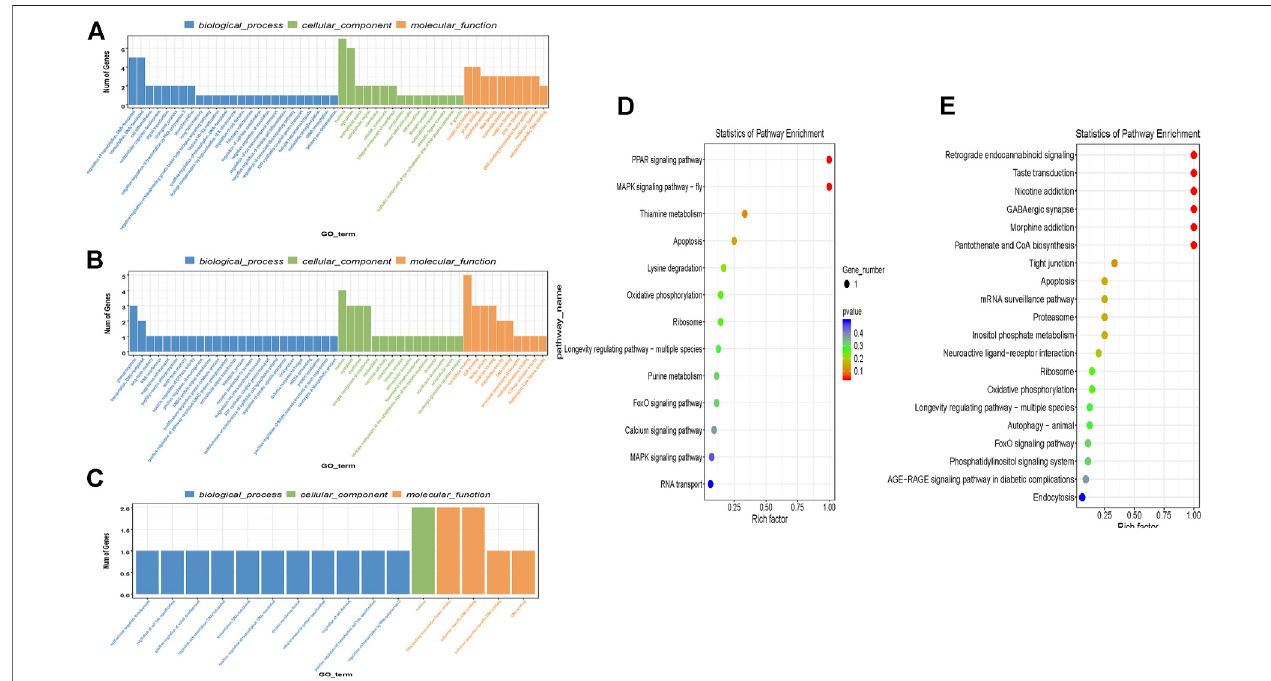
FIGURE3| GOandKEGGtermanalysisofdifferentiallyexpressedcircRNAsidenti fi edin Ascarissuum ovary-enrichedandbodywalltissues.Theparentalgenesof circRNAs differentially expressed between A. suum ovary-enriched and body wall samples were subjected to GO and KEGG analysis. (A-C) CircRNA-seq was performedinbiologicaltriplicate andGOanalyses ofparental genesgeneratingthedifferentially expressedcircRNAsbetweenovary-enriched andbodywalltissueswas identi fi ed in each sequencing run and are presented here. GO terms are binned according toprocess (biological process, cellular function, molecular function) and the number of genes in each bin are described on the y -axis. (D,E) Enriched KEGG terms for parental genes that derived differentially expressed circRNAs identi fi ed by comparing ovary-enriched andbodywalltissue samples.Oneofthethreesequencing runsdidnotyieldsigni fi cantdifferencesinthisKEGGanalysisand isnotincluded. Rich factor ( x -axis) is the ratio of the number of differentially expressed genes annotated in a pathway. The color and size of each bubble represent p -value and the number of genes enriched in a pathway.